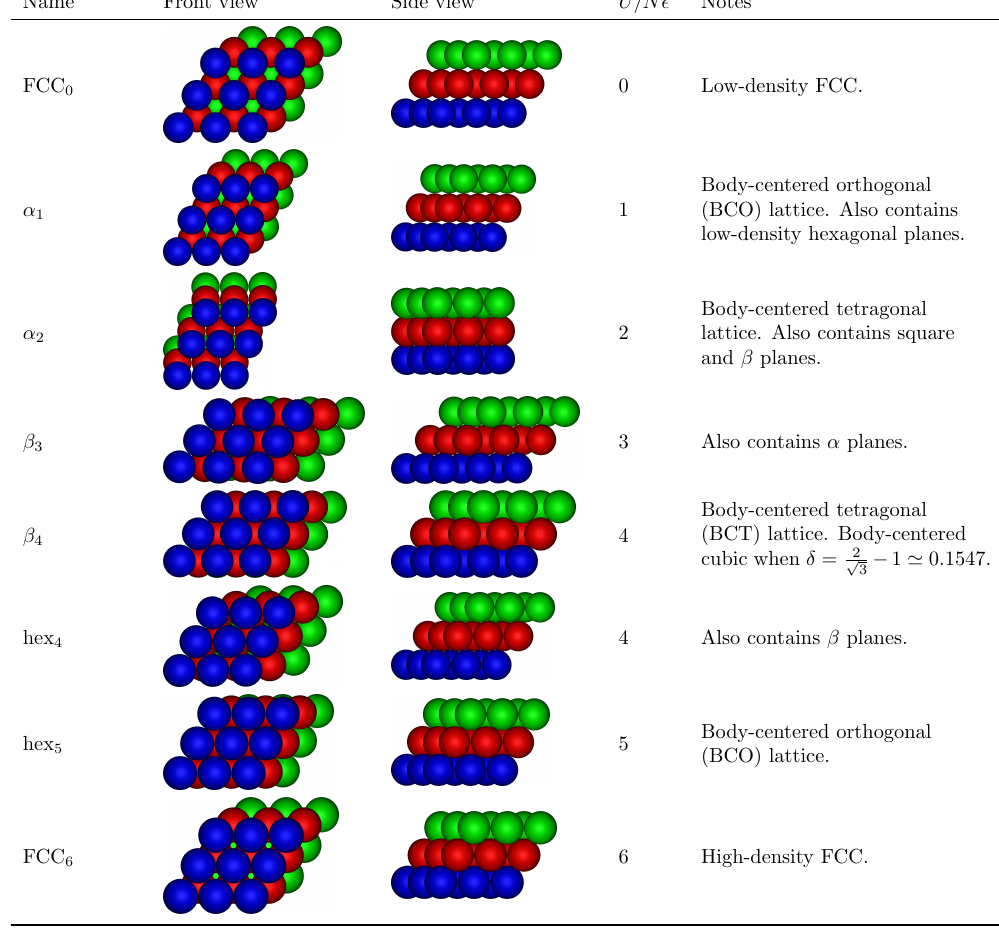
Figure 3. Graphical representations of stable ground-state crystal structures. For each crystal, we list a name, two snapshots with different planes highlighted in different colors, and any remarks on the details of the structure. In all snapshots, δ / σ = 0.2, with the exception of β 4 (with δ / σ = 0.15) and hex 4 (with δ / σ =